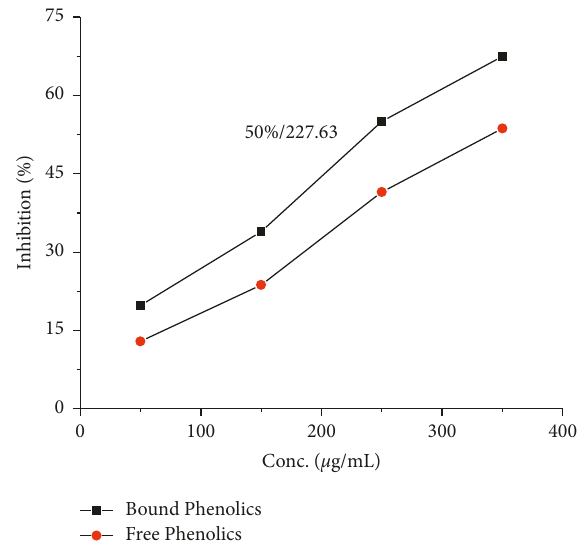
Figure 8: ACE (angiotensin-I converting enzyme) median in- hibitory potential of Schoenoplectus triqueter